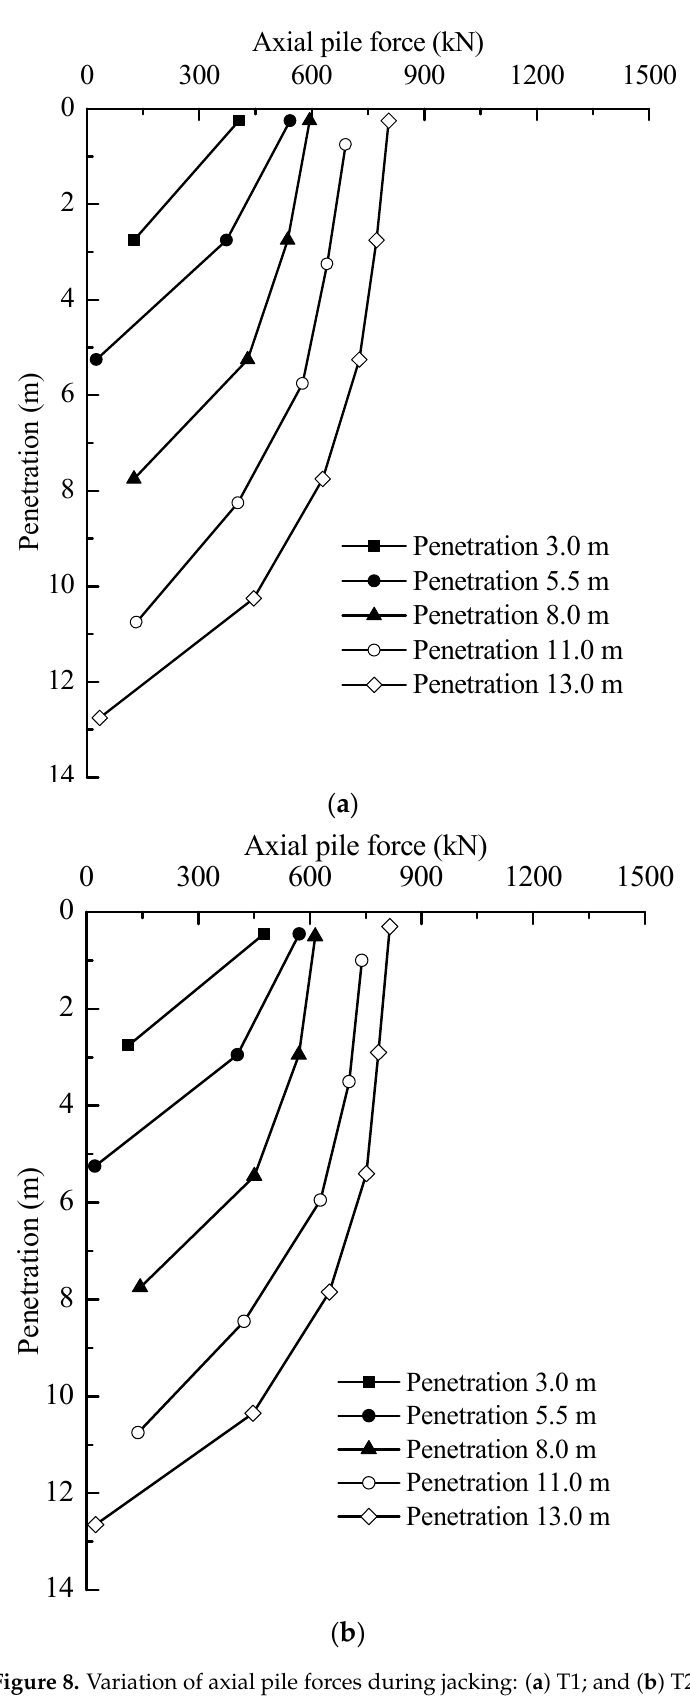
Figure 7. Jacking forces versus penetration depth.